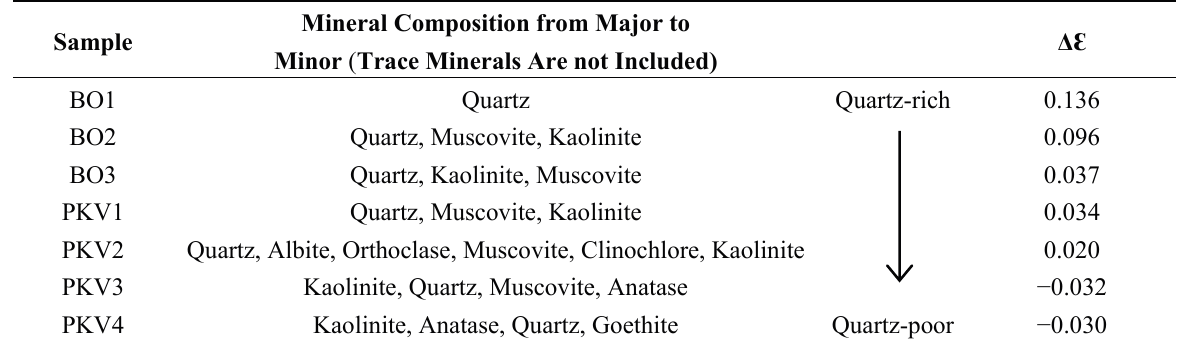
Table 1. Mineralogy of the land samples according to XRD analysis and their ΔԐ values calculated from the airborne data.